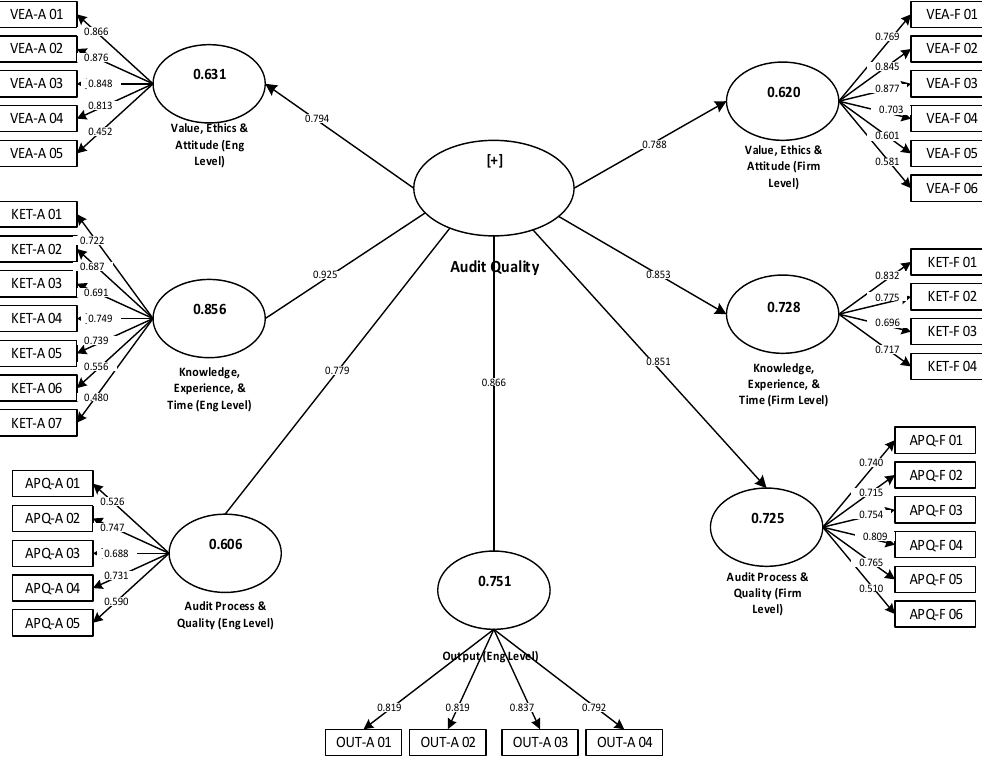
Fig. 2. Second Order Confirmatory Factor Analysis of Attributes of Audit Quality